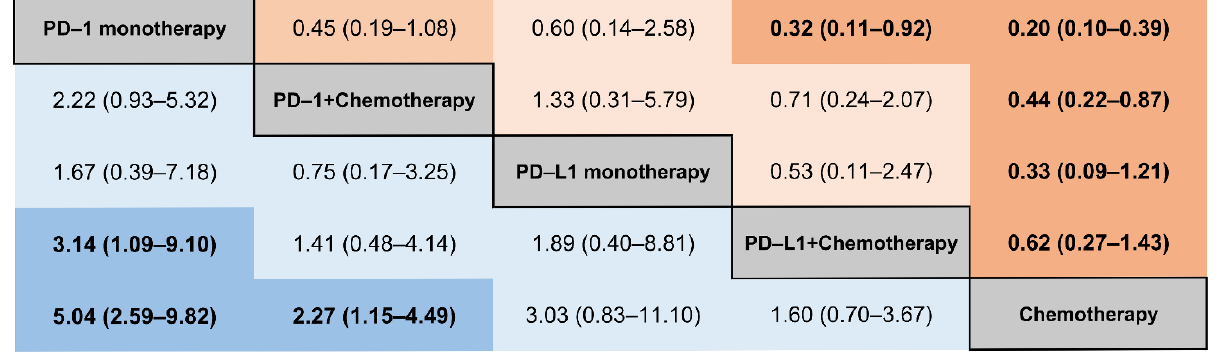
Figure 6. Different ICI comparisons for grade 3–5 IRPs based on network consistency model. Comparisons should be read from left to right. RRs for comparisons are in the cell in common between the column ‐ defining and row ‐ defining treatment, bold numbers with darker background are statistically significant; values that were borderline significant are in a lighter shade. An RR > 1 means the treatment in the top left is worse. The numbers in parentheses represents 95% confidence intervals.